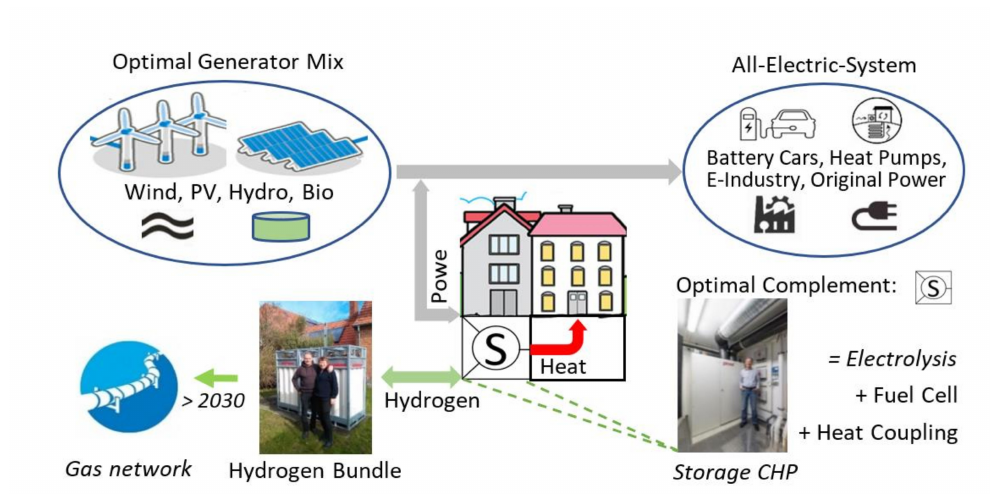
Figure 1. Decentral 100% renewable energy system with Storage CHP.